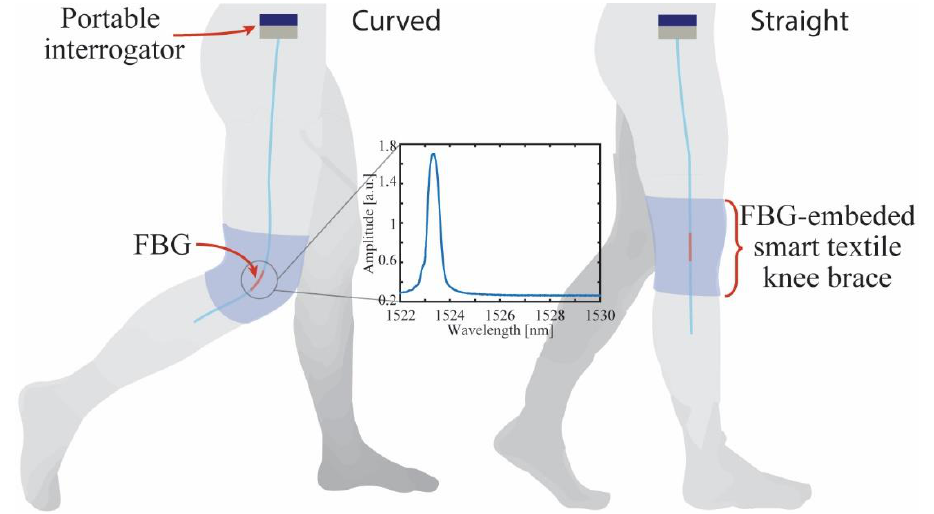
Figure 3. Schematic representation of the FBG-embedded smart textile for knee angle and displacement assessment. The inset shows the grating spectrum acquired by the portable interrogator.